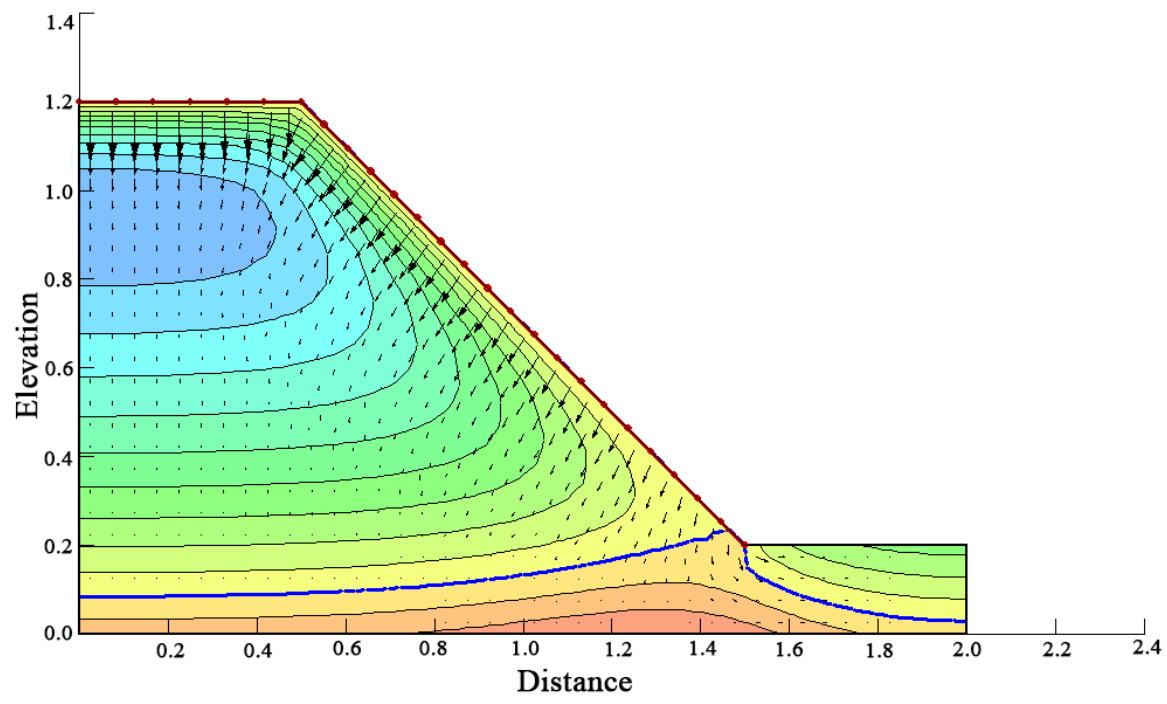
Figure 9. Changes of the slope phreatic line and seepage field after 1 h of rainwater infiltration.